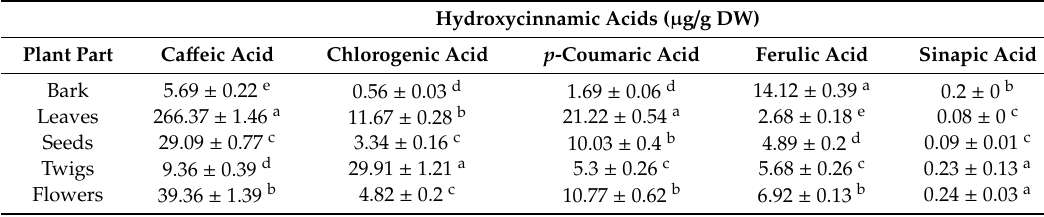
Table 5. Quantity ( µ g / g DW) of hydroxycinnamic acids in 80% methanol Protea ca ff ra extracts. Values represent mean ± standard error, n = 3.